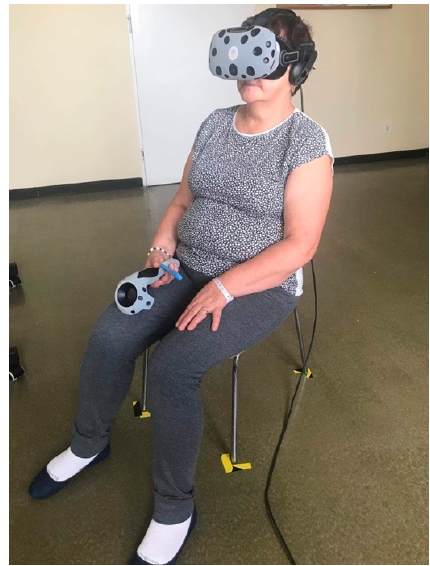
Figure 2. A station for relaxation in